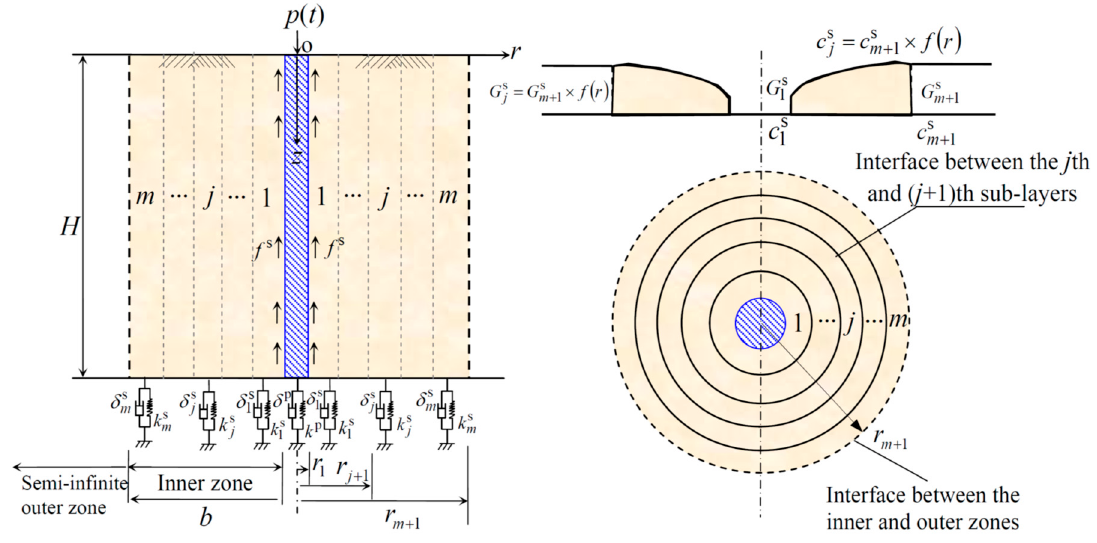
Figure 1. The simplified mechanical model.